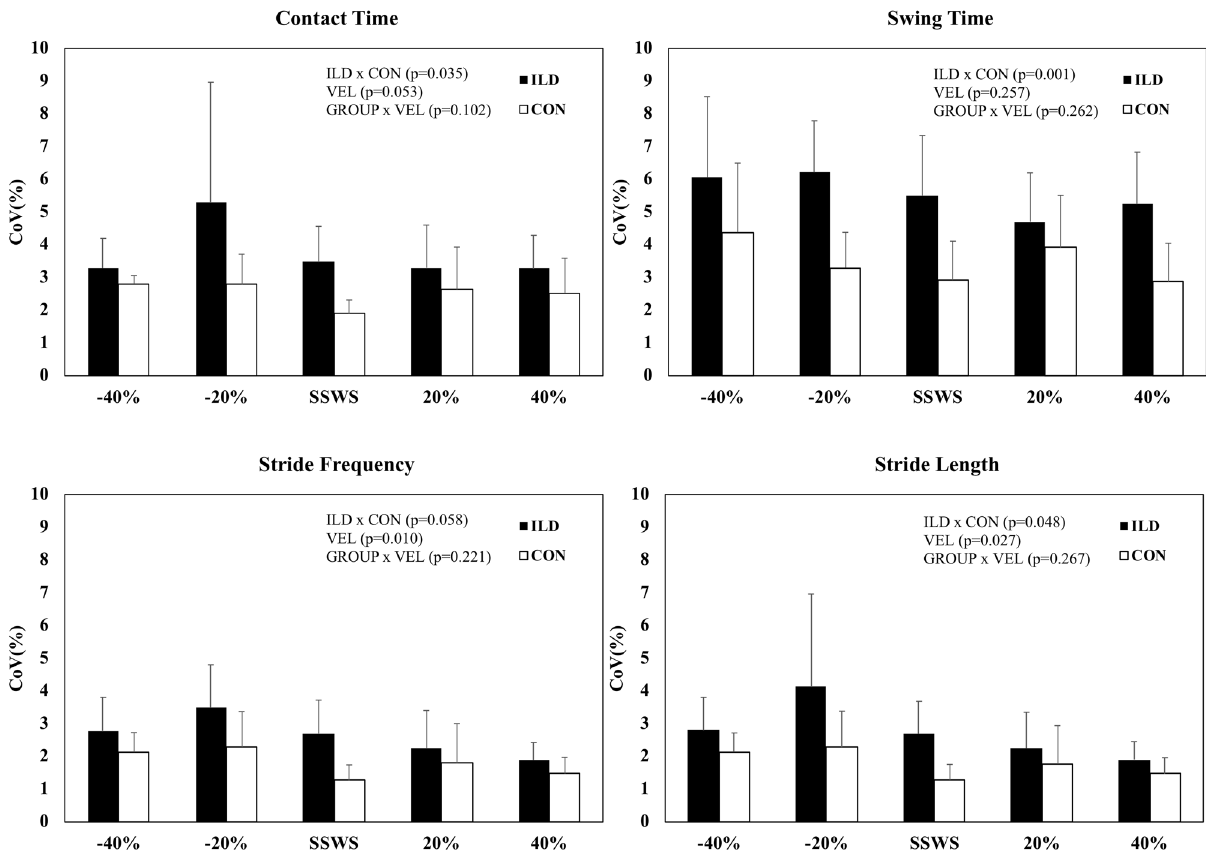
Figure 3. The coefficient of variation (CoV) of contact time, swing time, stride frequency and stride length as a function of self-selected walking speed (SSWS), and two relative speeds below and two above SSWS in patients with interstitial lung disease (ILD, filled columns) and controls (empty columns). The main [group (ILD × CON) and velocity (VEL)] and interaction (GROUP × VEL) effects are